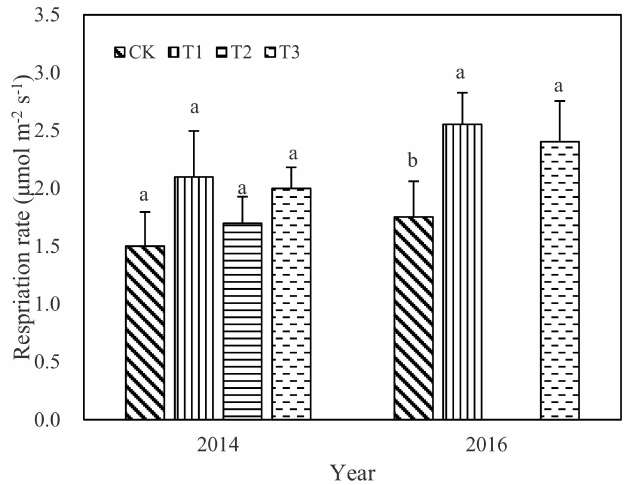
Figure 8. Ear leaf respiration rate (R) at blister stage. CK, T1, T2, and T3 denote the control, nocturnal warming during the whole growth season, and nocturnal warming during the vegetative and reproductive stages, respectively. The same letters on the pillar indicate no significant difference among the treatments in the same year ( p <